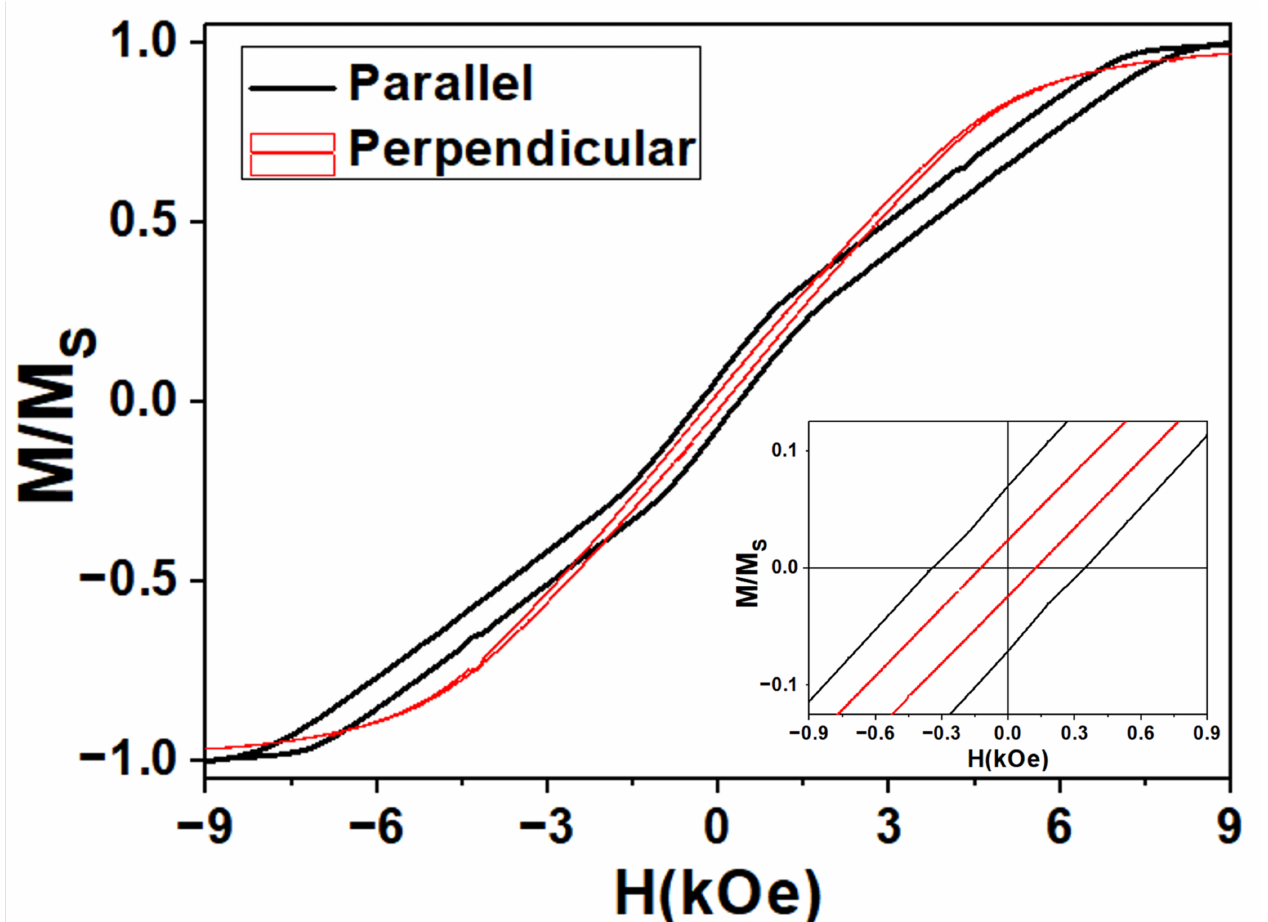
Figure 3. Room temperature hysteresis loops under parallel (black) and perpendicular (red) applied field direction with respect to the nanowires’ long axis. The inset shows a zoom into the low-field